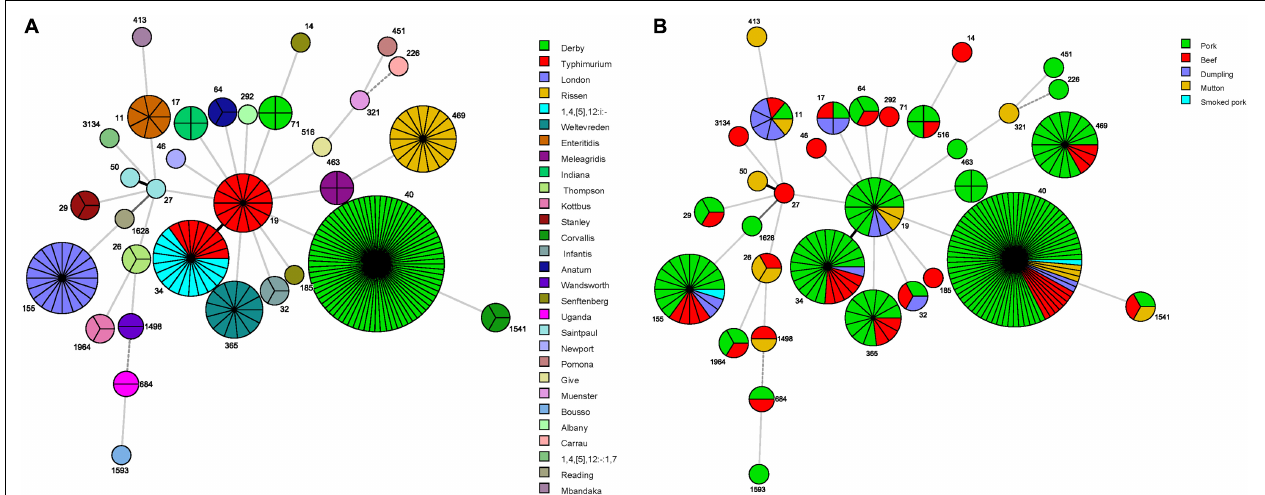
FIGURE 1 | Minimum spanning tree based on multilocus sequence typing data for the 218 Salmonella isolates examined in this study. Each circle represents one ST, subdivided into one sector per isolate, flanked by the ST number in small print. The size of circle is related to the number of strains within this ST. The colors in the circles in (A) represent the serovars, and the colors in the circles in (B) represent the food sources.